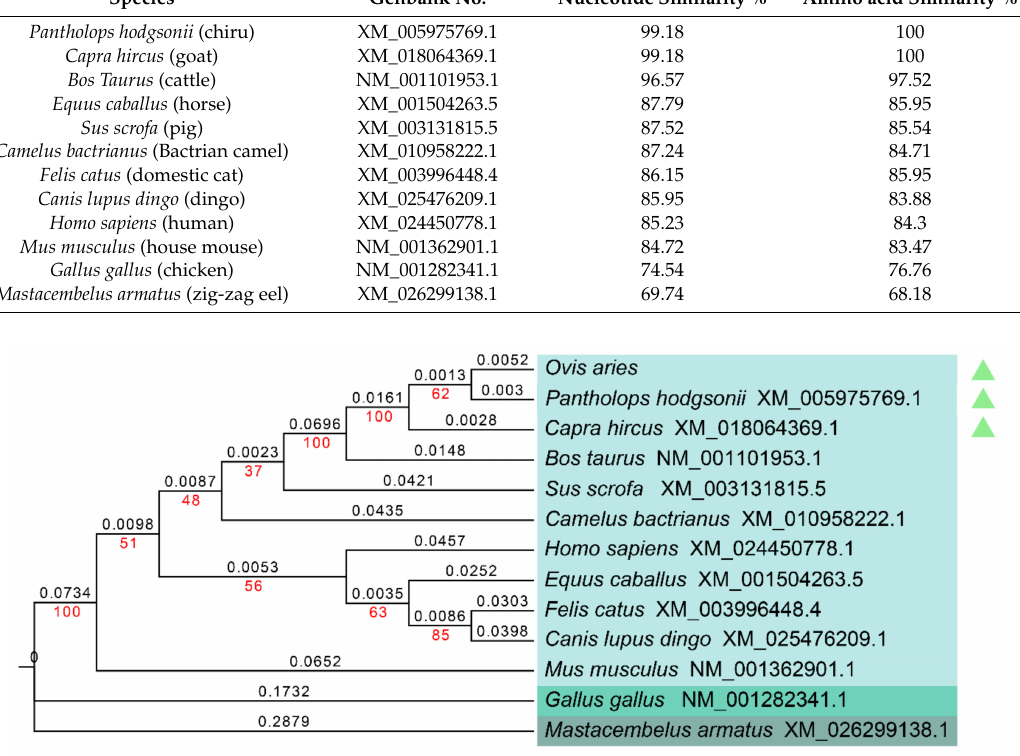
Figure 4. Evolutionary relationships of the GLOD4 gene among di ff erent species. The optimal tree with the sum of branch length = 1.20380259 is shown. The bootstrap values (red) and branch lengths (black) are shown next to the branches. The green arrow indicates that the sheep GLOD4 gene has the closest homology to chiru ( Pantholops hodgsonii ) and goat ( Capra hircus